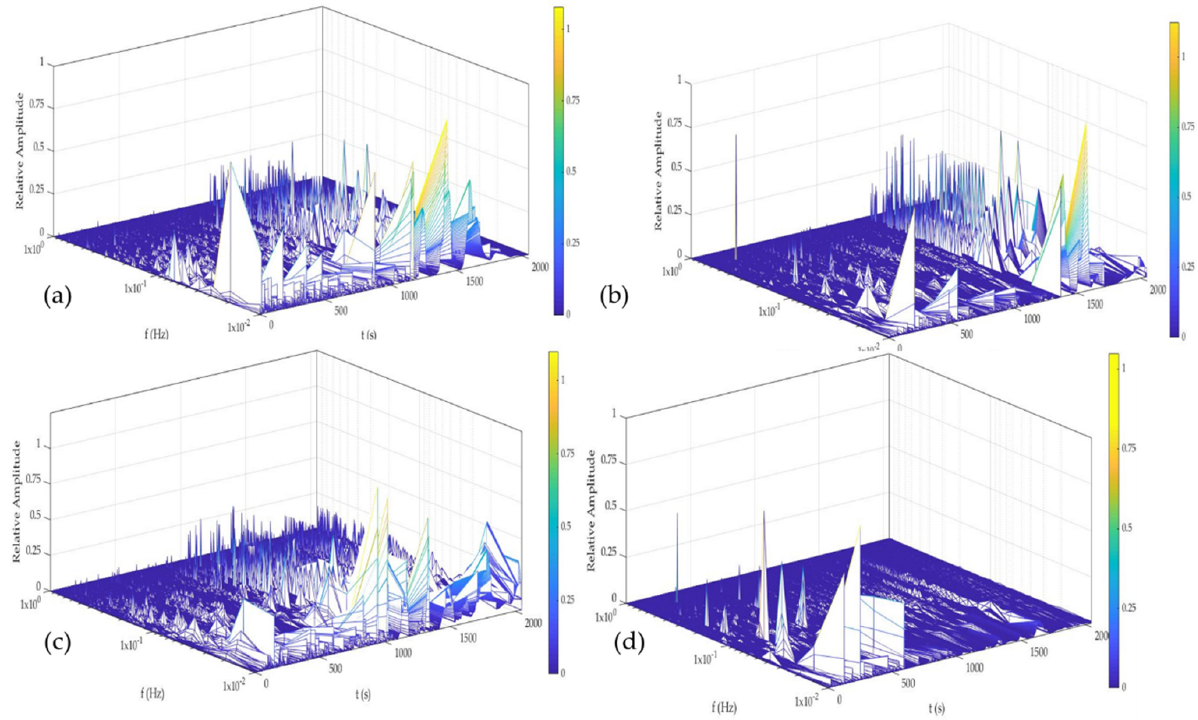
Figure 14. Hilbert spectra of Al-6061 in H2O solution ( a ) 0 h, ( b ) 24 h, ( c ) 48 h, and ( d ) 120 h.